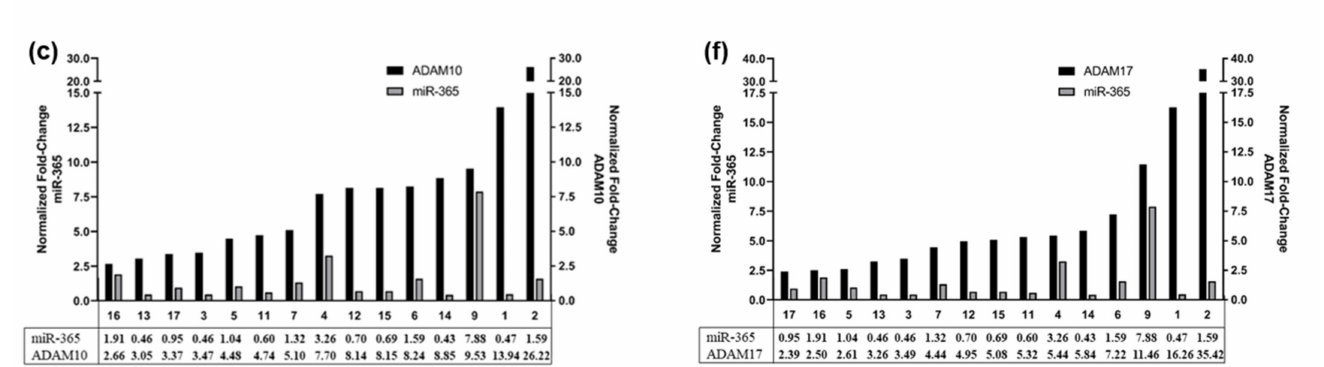
Figure 11. Correlation of miRNA-145, miRNA-152 and miRNA-365 expression with ADAM10 ( a – c ) and ADAM17 ( d – f ) expression levels in 15 individual RB patients as revealed by real-time